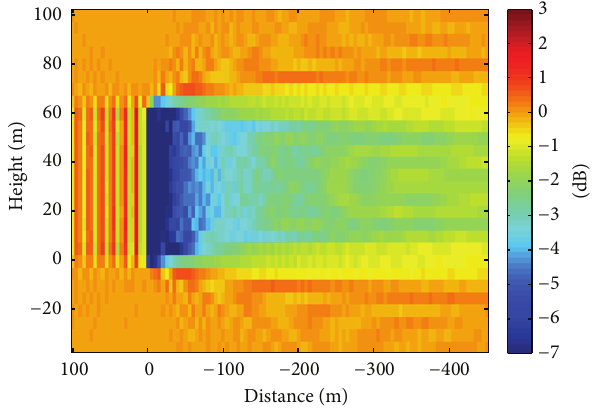
Figure 5: Near-field distribution around a 3D finite cylinder in the vertical cut plane along the incident field direction computed using MLFMM. The field inside the shadow region is relatively uniform for different observation heights.